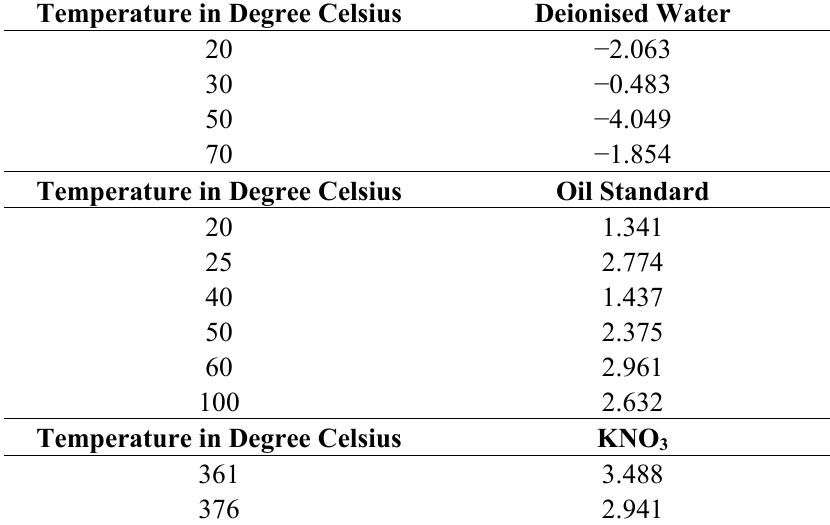
Figure 2. Three graphs showing the difference between experimental data in black to that of published data in red. Water ( a ), calibration oil ( b ) and KNO 3 ( c ) were used as reference and viscosity was plotted against temperature [1,11,12]. Table 2. Percentage difference between the average measurement and the referenced